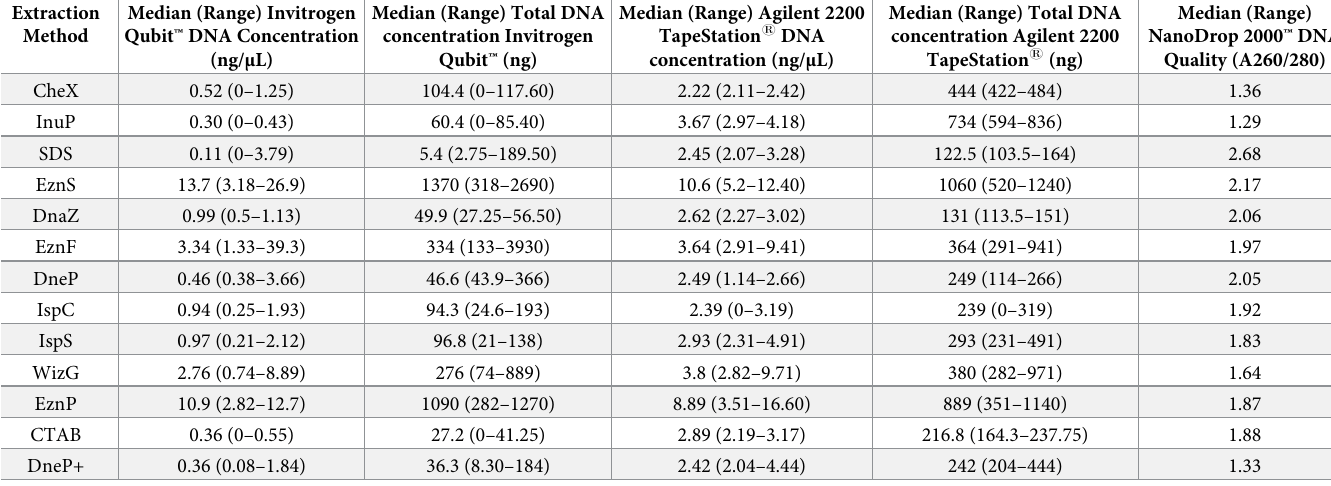
Table 2. Median and range of total DNA concentration (ng/ μ L) and DNA quality (A260/280) produced by 13 extraction protocols tested on five victorian plant pathology herbarium (VPRI) apple powdery mildew specimens. Extraction